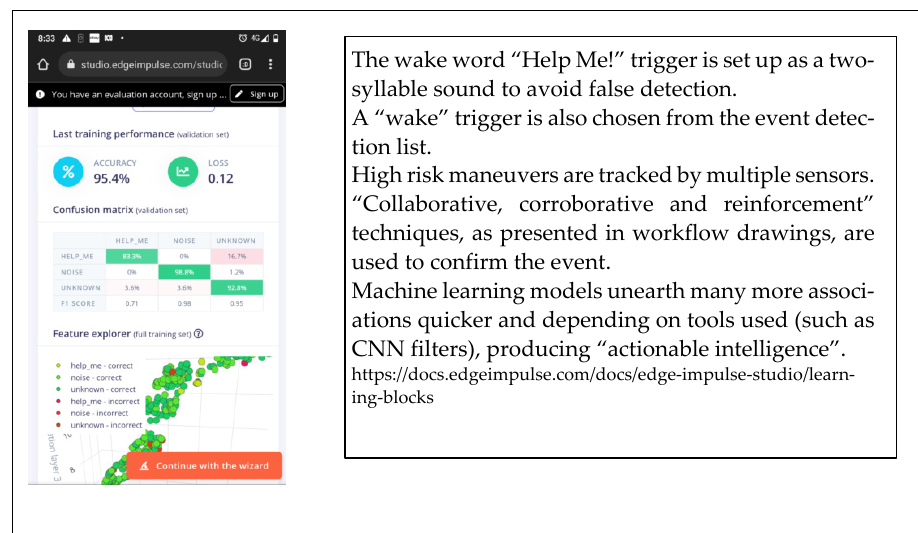
Figure 28. The wake word “Help Me!” turns on event recognition computing resources.